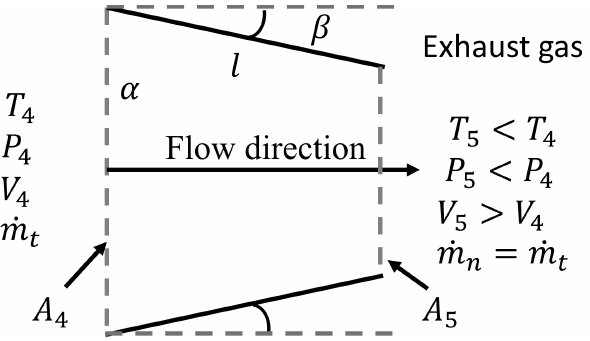
Figure 1. Diagram of variable exhaust nozzle geometrical